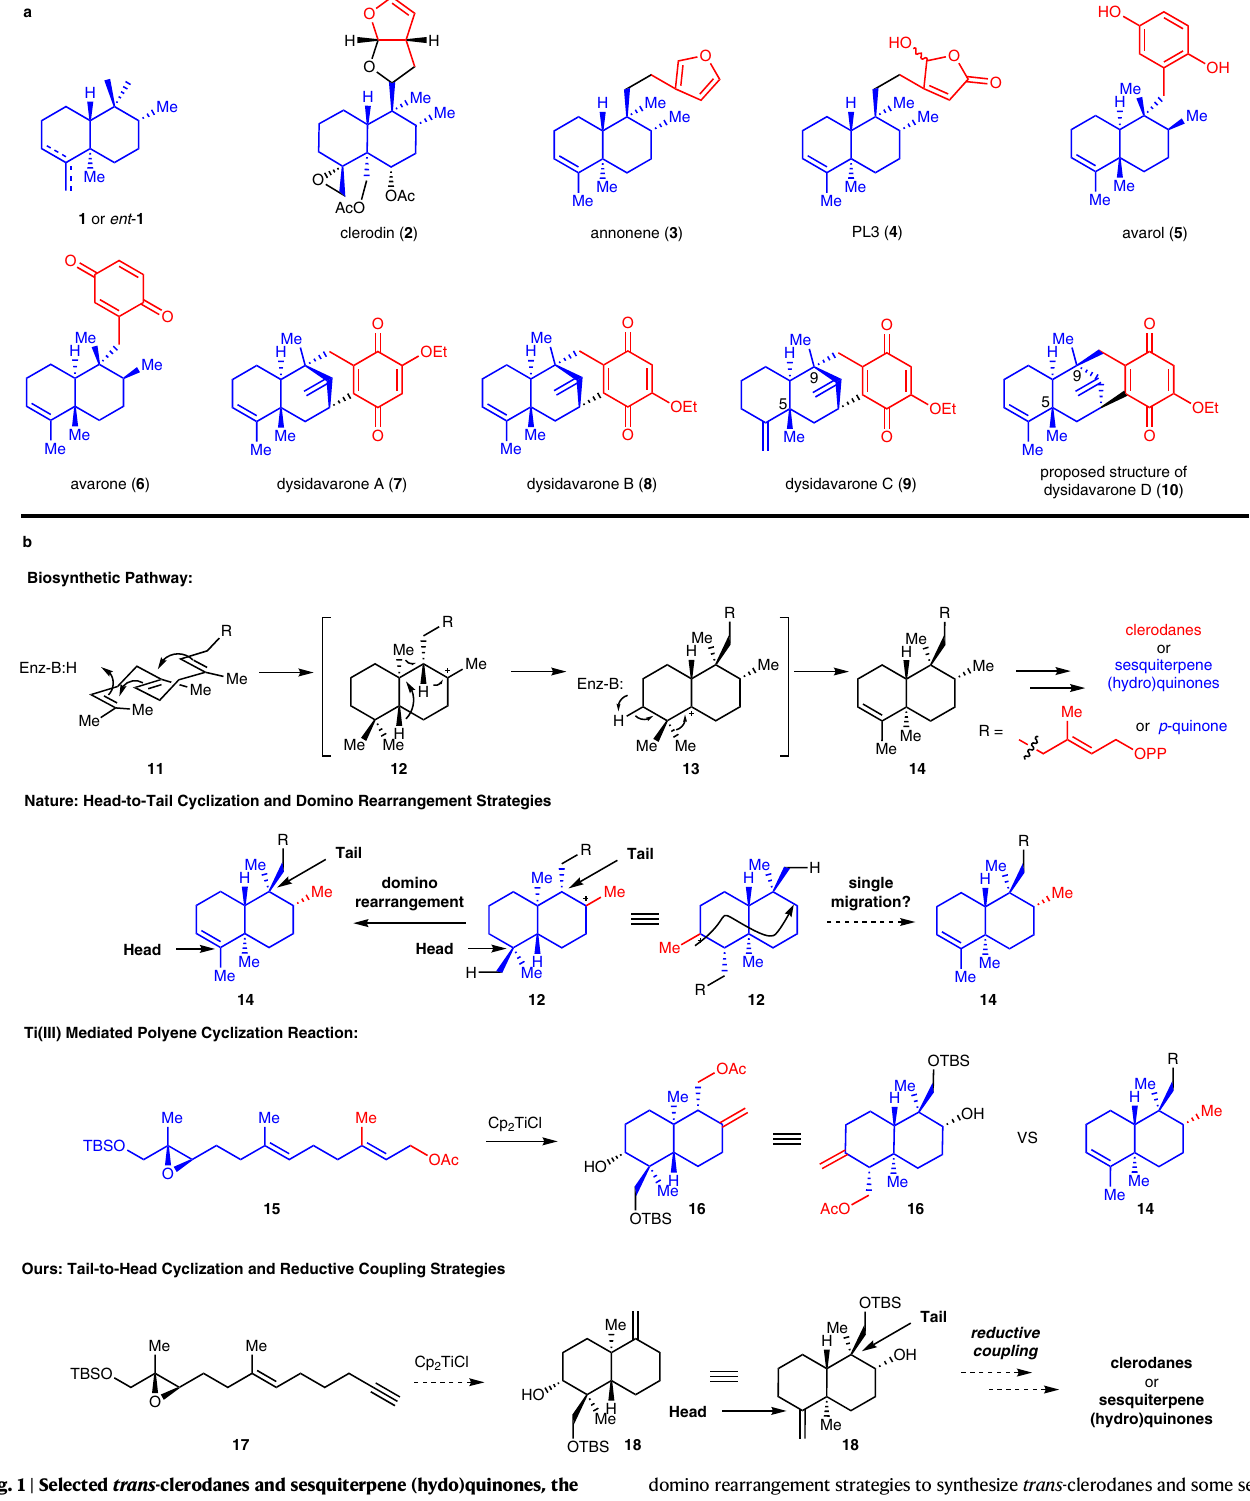
domino rearrangement strategies to synthesize trans -clerodanes and some ses- quiterpene (hydo)quinones. Our ’ s tail-to-head cyclization and reductive coupling strategies to synthesize these types of natural